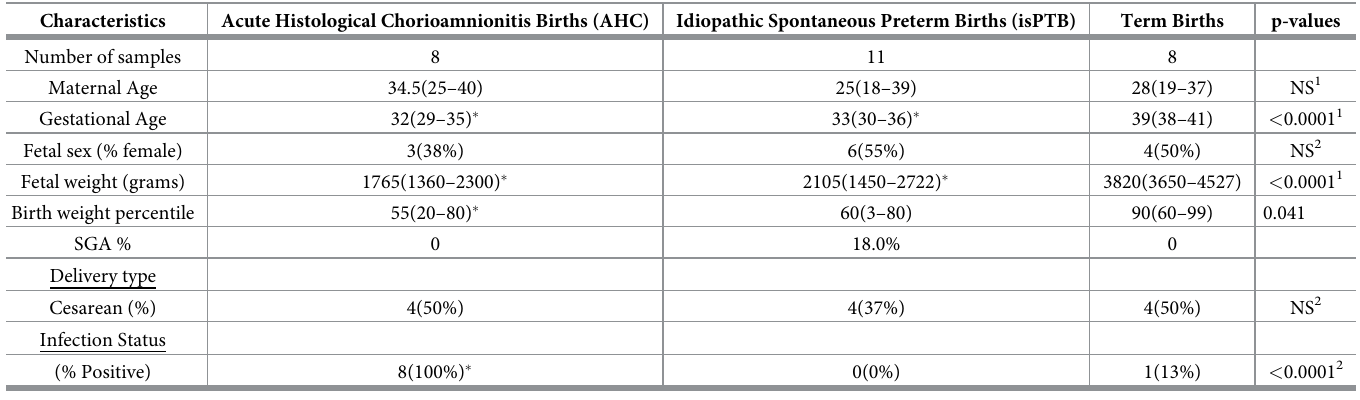
Table 1. Clinical characteristics of the placental villous samples included in this